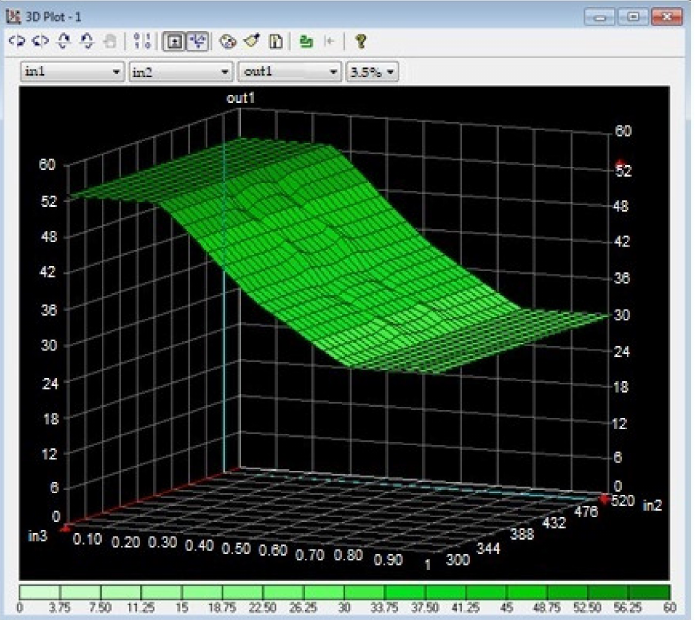
Figure 10. Surface plot out1 (optimal speed of the vehicle approaching the intersection) ( in2 (the vehicle’s distance to the start of the intersection), and in3 (the proportion of large vehicles waiting at the